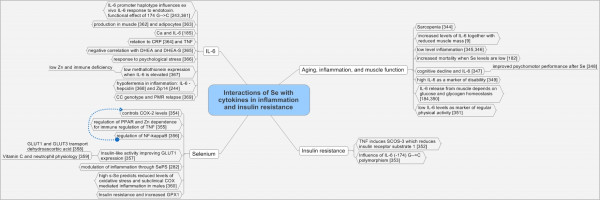
Graphical summary of scientific data related to inflammation as it can be applied in TAO and in metabolic disorders including insulin resistance. Interactions with IL-6 and Se are depicted.